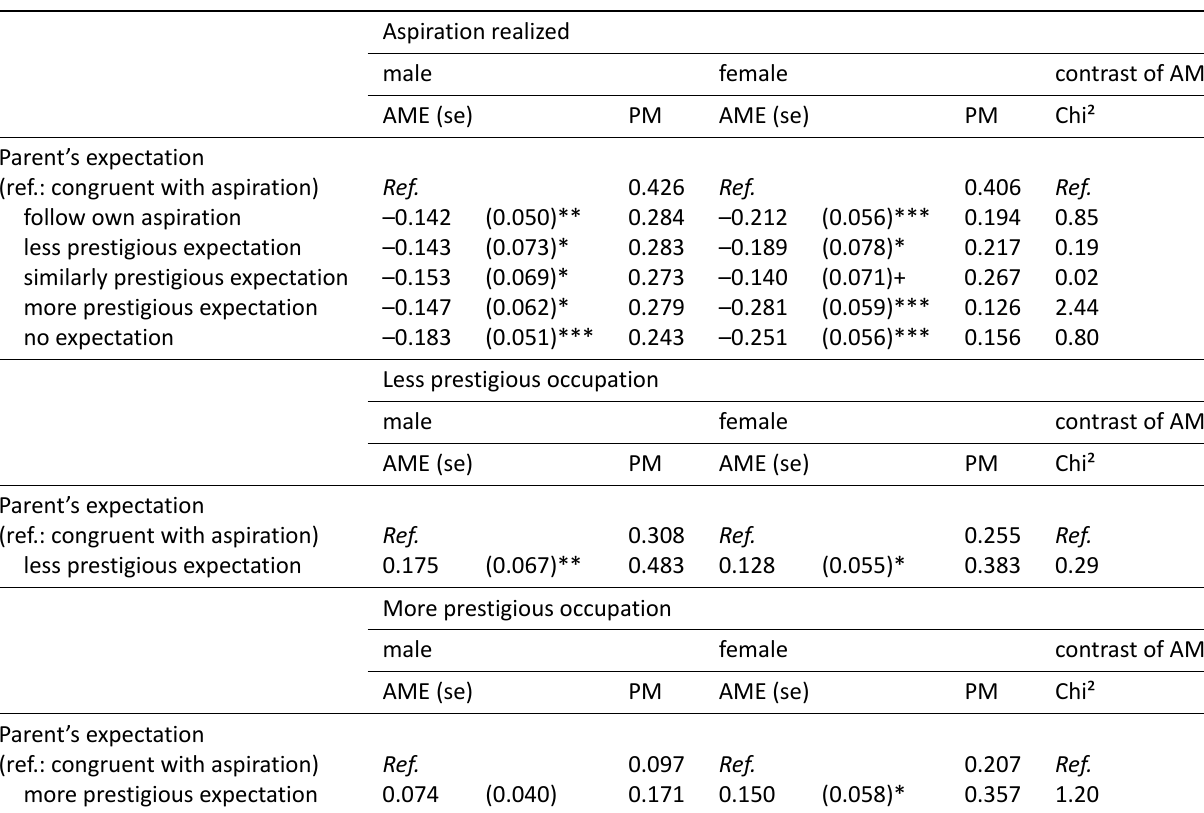
Table 2. Gender‐differences in the effects of divergent parental expectations on compromise formation (selected